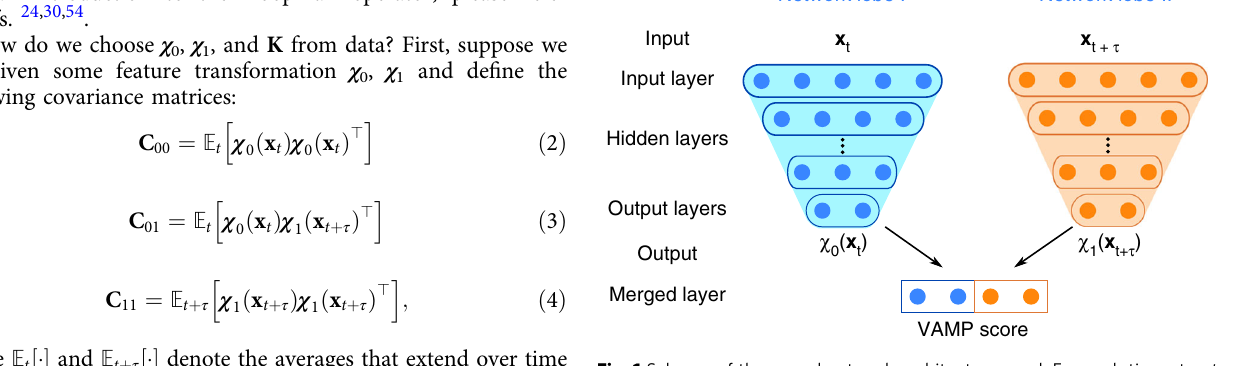
Fig. 1 Scheme of the neural network architecture used. For each time step t of the simulation trajectory, the coordinates x t and x t + τ are inputs to two deep networks that conduct a nonlinear dimension reduction. In the present implementation, the output layer consists of a Softmax classi fi er. The outputs are then merged to compute the variational score that is maximized to optimize the networks. In all present applications, the two network lobes are identical clones, but they can also be trained